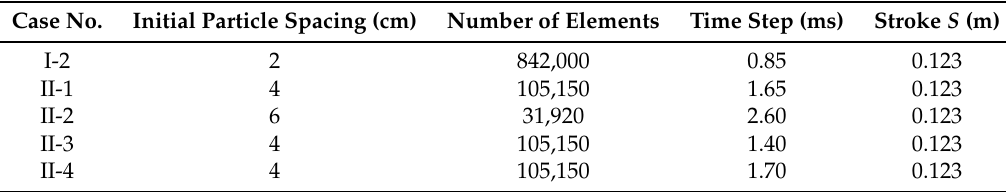
Table 4. Initial particle spacing and time step for parametric studies.